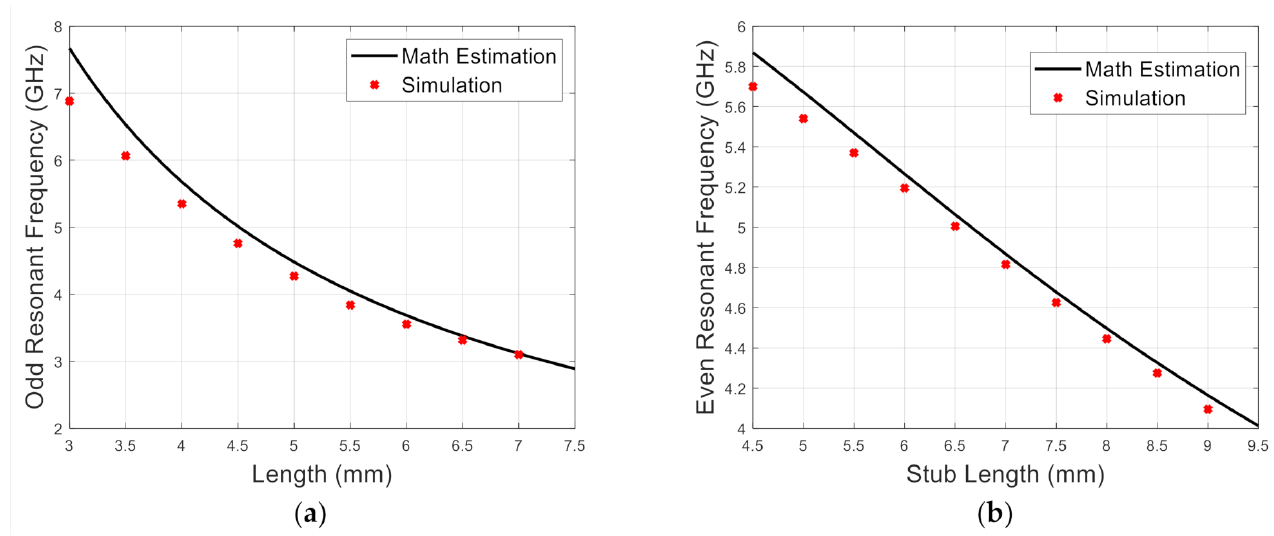
Figure 3. A comparison between the SL-MMR estimated and the CST Micriwave Studio simulated resonant frequencies for: ( a ) odd mode (variable L (cid:48) ); and ( b ) even mode (variable L).